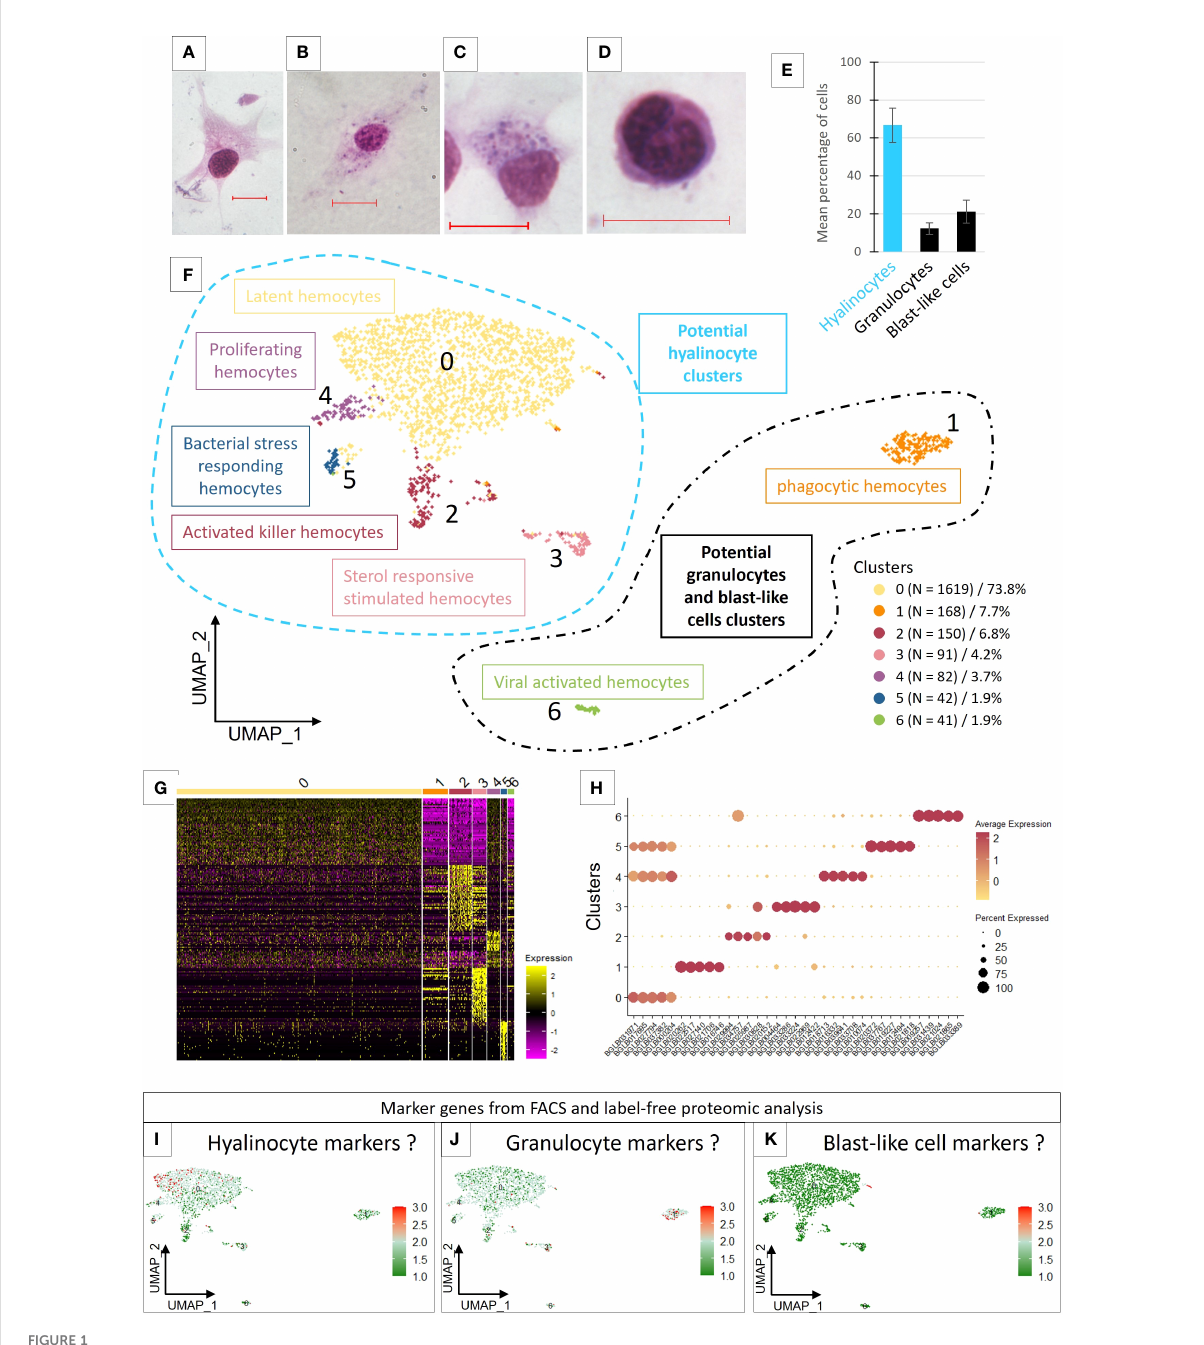
FIGURE 1 (A – D) Light microscopy observation of MCDh-stained hemocytes. Red bars 10µm. (A) hyalinocyte; (B, C) granulocytes; (D) blast-like cell. (E) Average number of hemocytes (1844 cells total) from 10 naive individuals according to three morphological types. (F) Uniform Manifold Approximation and Projection for Dimension Reduction (UMAP) plot of the 7 hemocyte clusters identi fi ed in B glabrata by scRNA-seq and their respective count of the cell number present in each transcriptomic cluster. (G) Heatmap representing the differential expression of the top 50 marker genes de fi ned for each of the 7 transcriptomic clusters. (H) Dotplot representing the average expression of the 5 genes de fi ned as markers for each cluster according to the percentage of cells expressing these genes per cluster. (I – K) represent the average expression levels of the genes de fi ned as markers by the fl ow cytometry approach coupled with label free proteomics. Dotplot and UMAP representation of marker genes average expression of hyalinocyte (I) , Granulocyte (J) and blast-like cells (K)